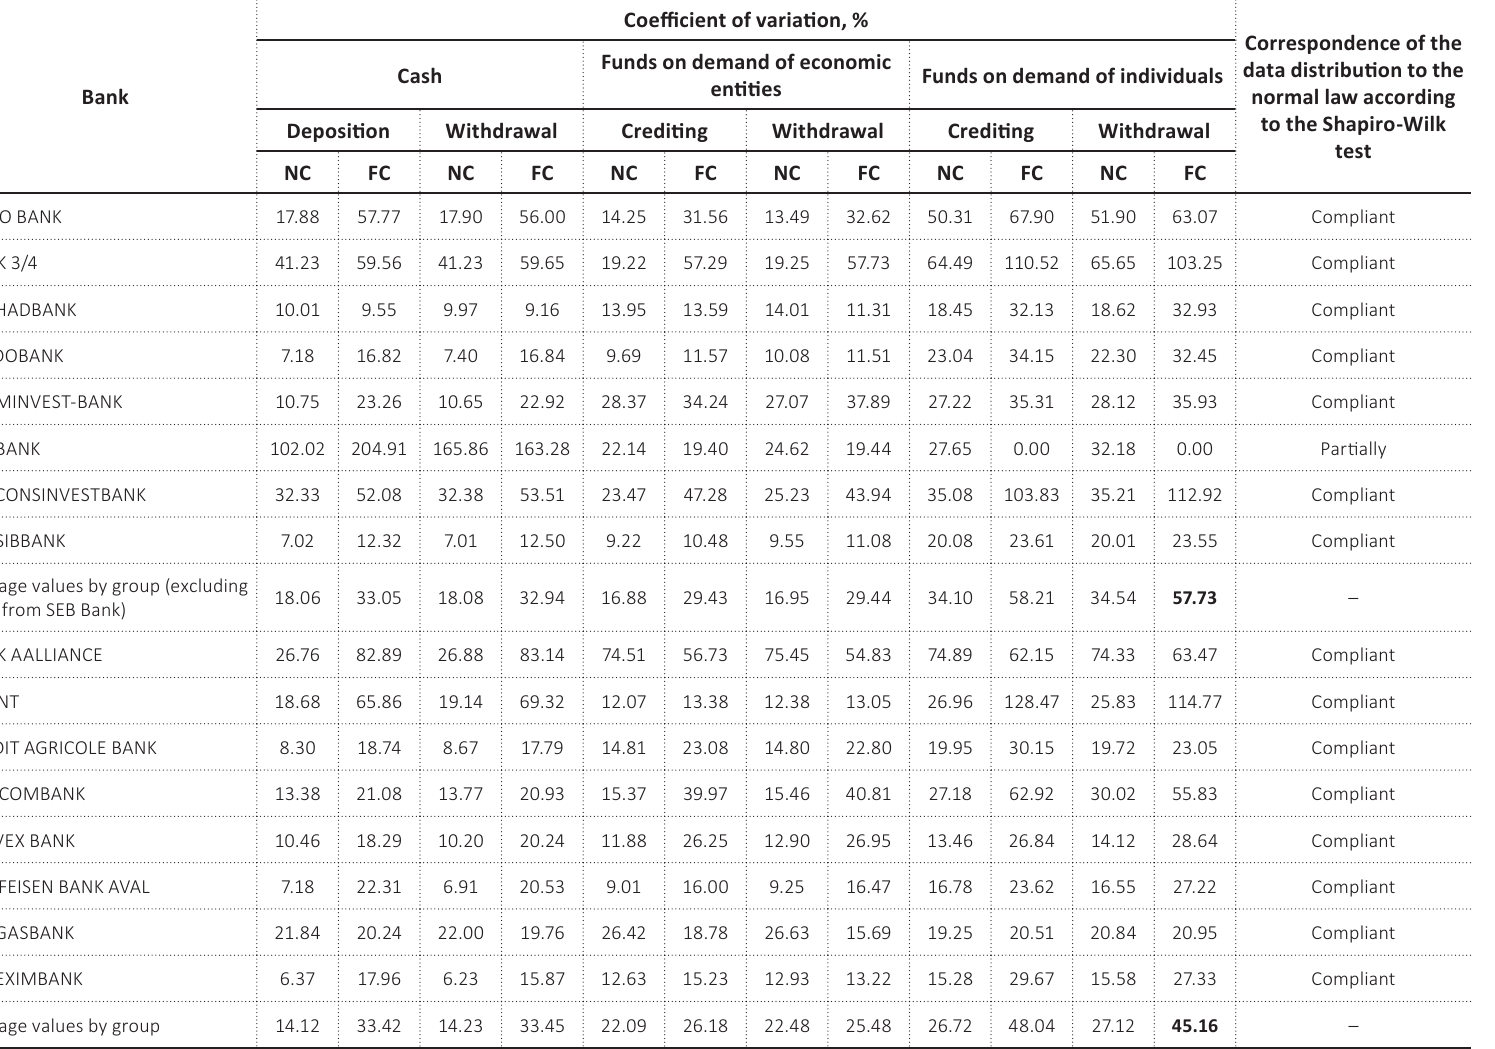
Table 6 (cont.). Generalized results of calculating the coefficient of variation of cash flow by cash registers and accounts on demand of bank